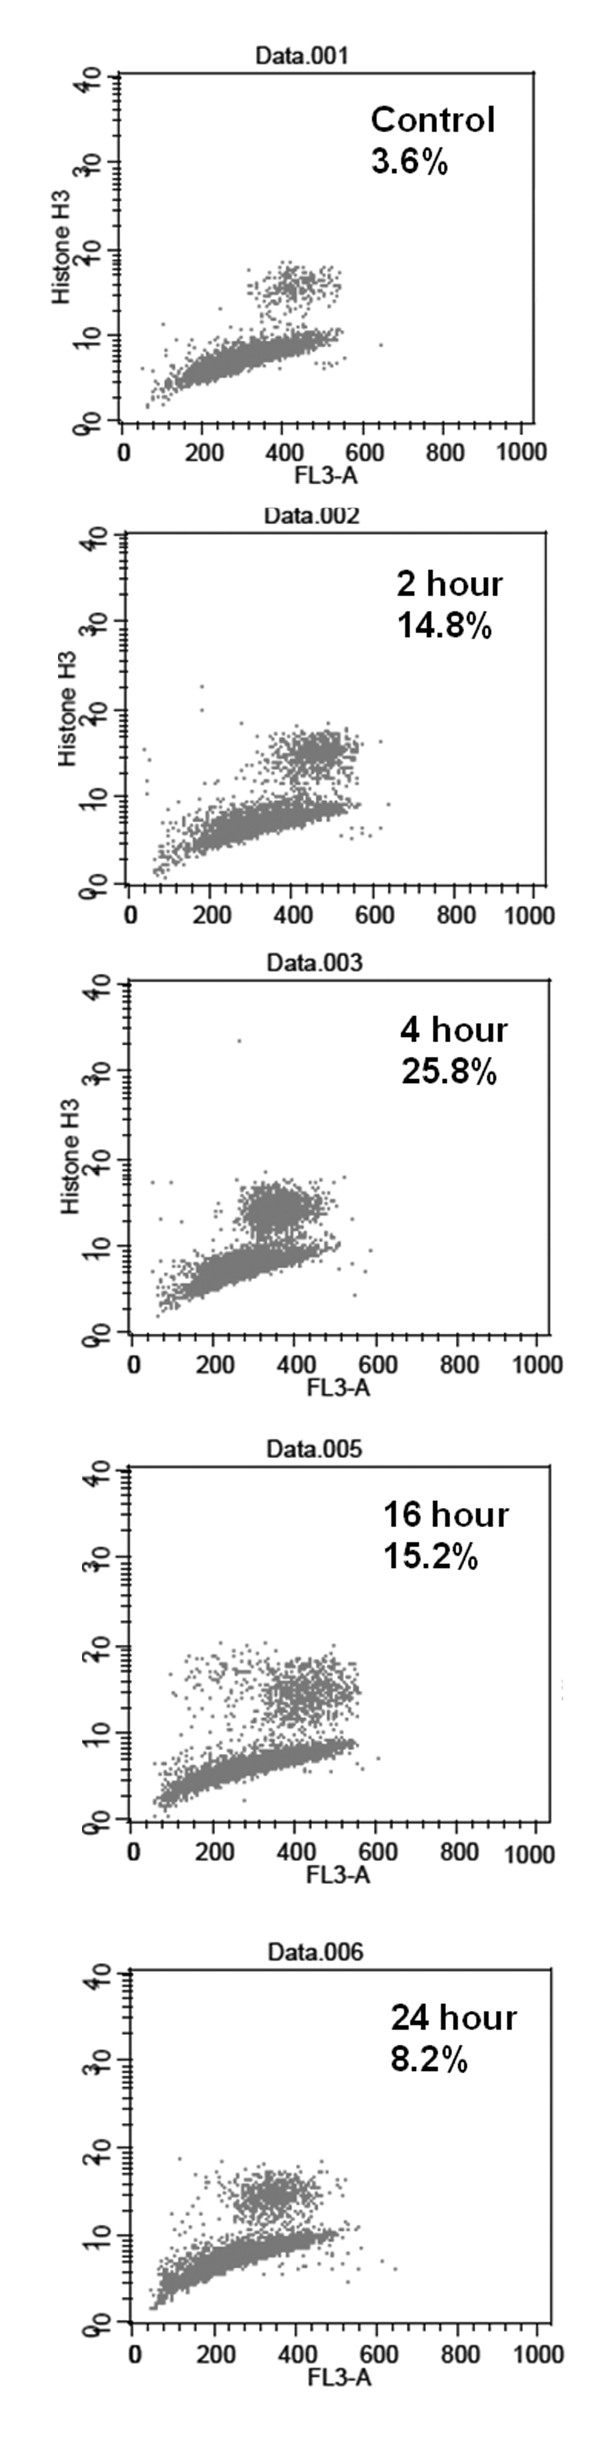
Flow cytometric analysis for expression of phosphorylated histone H3 (Ser 10) in costunolide-treated HA22T/VGH cells. Cells were treated with costunolide (5 μM for various time periods as indicated). Representative dot-plot visuals were demonstrated.